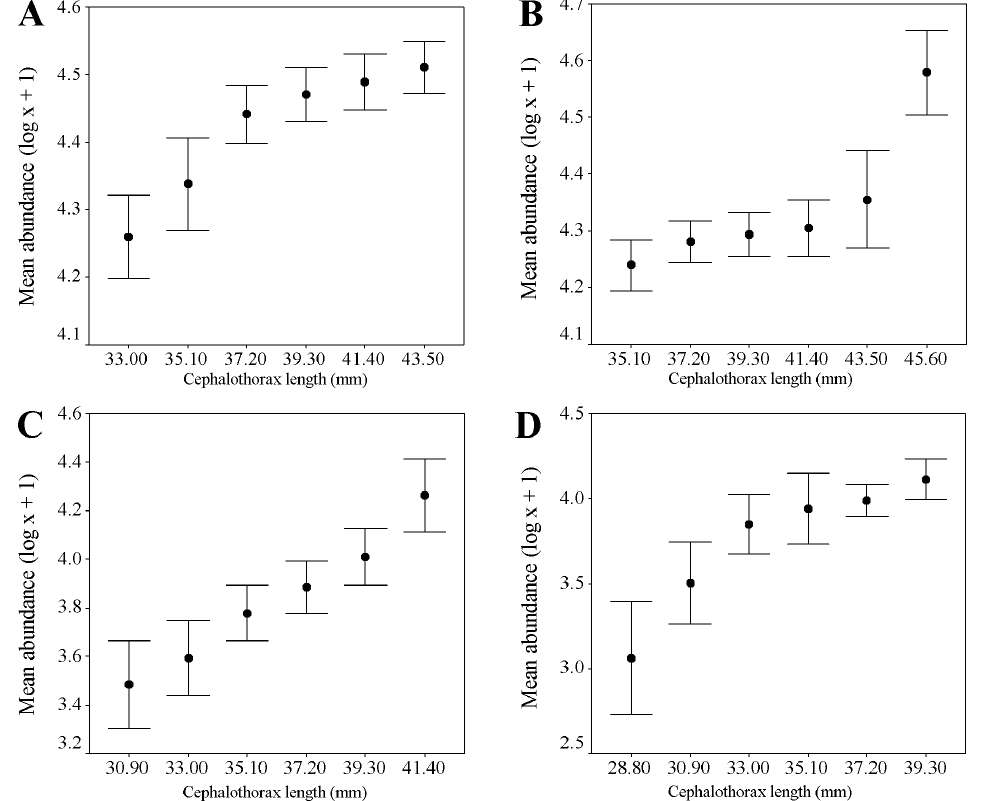
Figure 6. Relationship between mean abundance of cysts (log x + 1) of Microphallus nicolli and size-classes of females of Emerita rath- bunae based on cephalothorax length. Data are for all four localities: San Andrés ( A ), Revolcadero ( B ), Las Trancas ( C ), and Ixtapa ( D